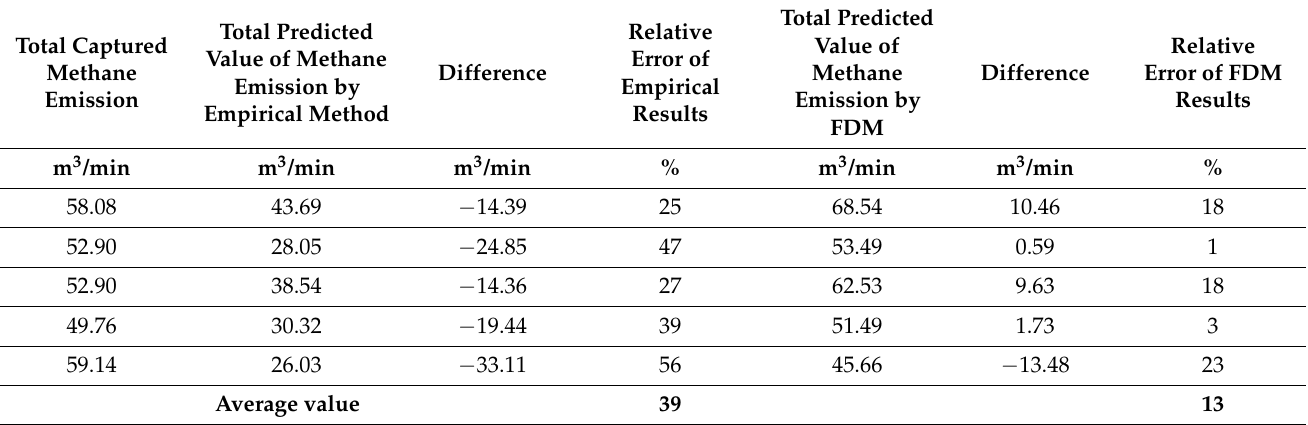
Table 6. Total captured methane emission obtained by means of the empirical method and FDM